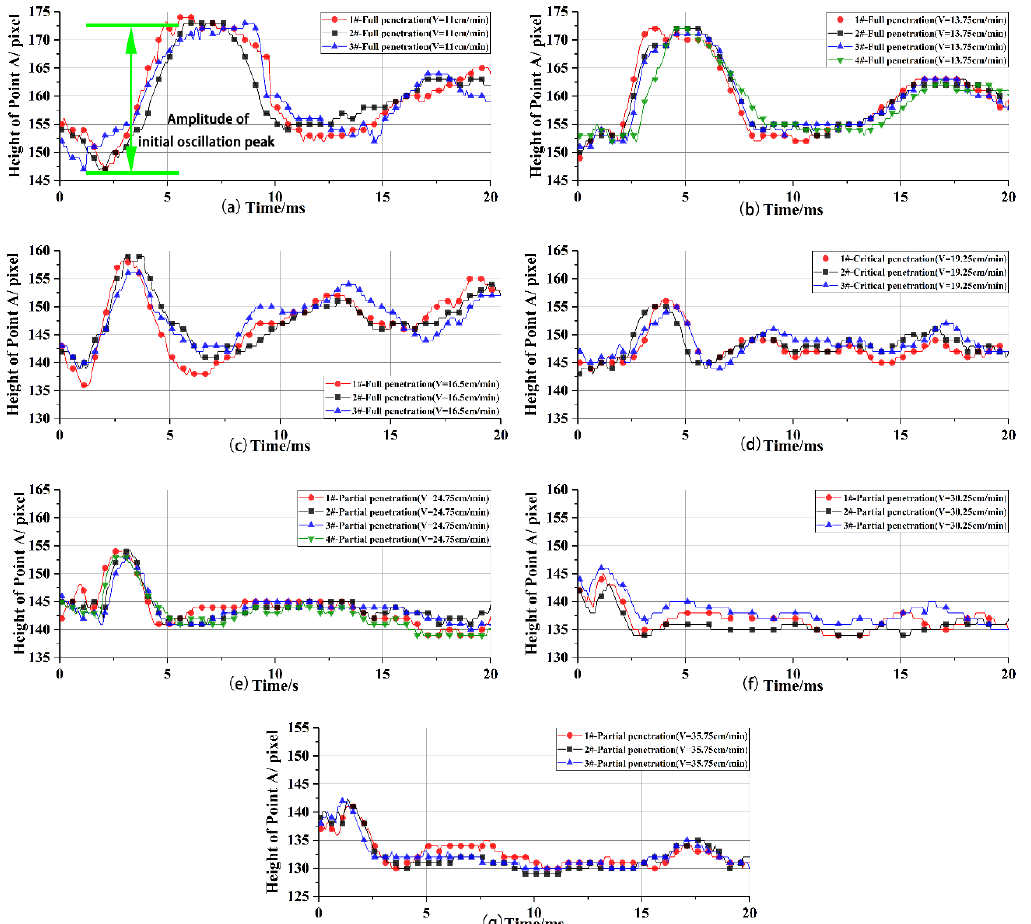
Figure 6. The height of the reference point A on the weld pools surface as a function of time. Full penetration: ( a ) V = 11 cm/min; ( b ) V = 13.75 cm/min; ( c ) V = 16.5 cm/min. Critical penetration: ( d ) V = 19.25 cm/min. Full penetration: ( e ) V = 24.75 cm/min; ( f ) V = 30.25 cm/min; ( g ) V = 35.75 cm/min.